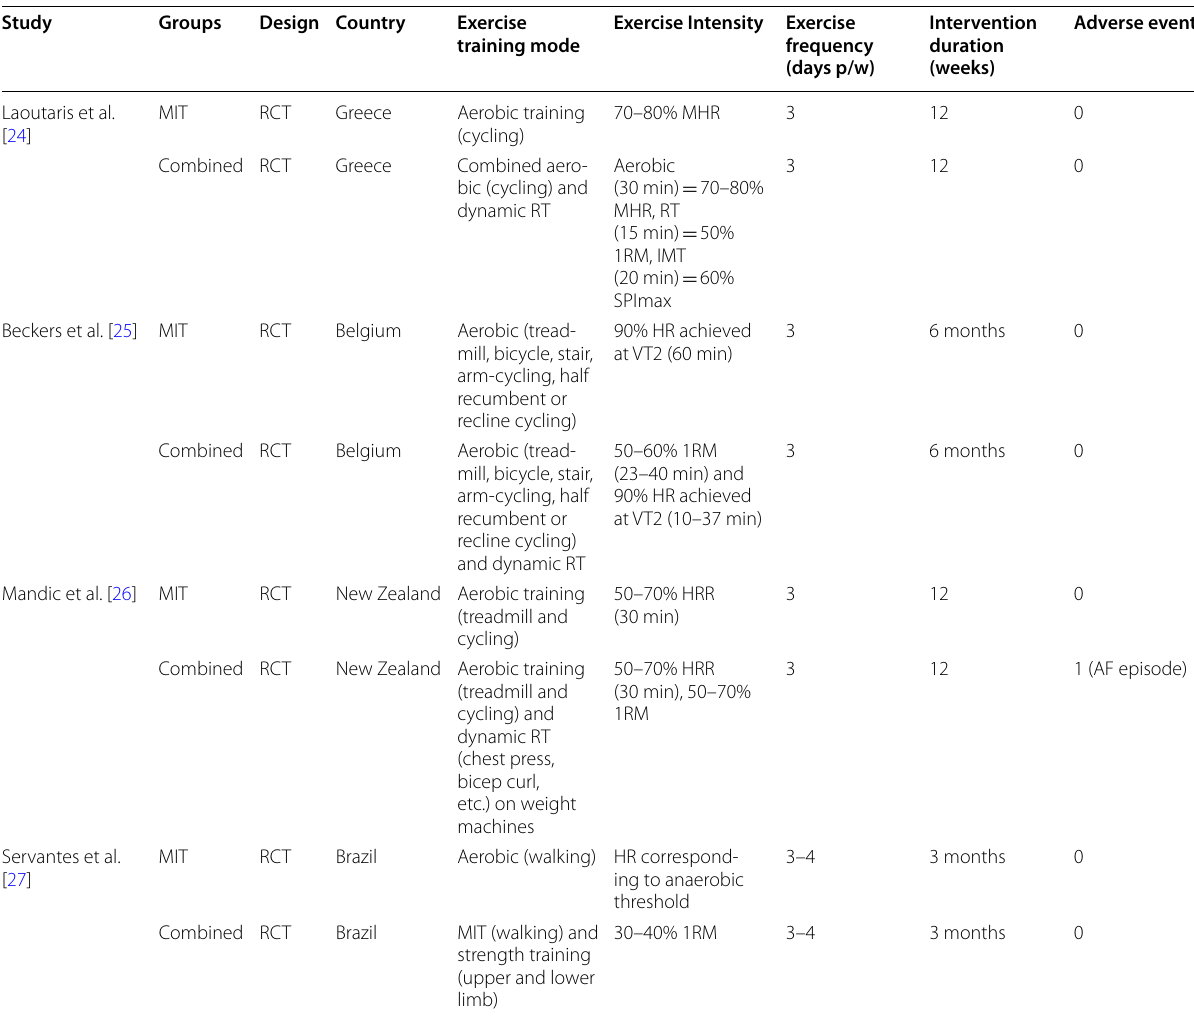
Table 1 MIT versus CT training